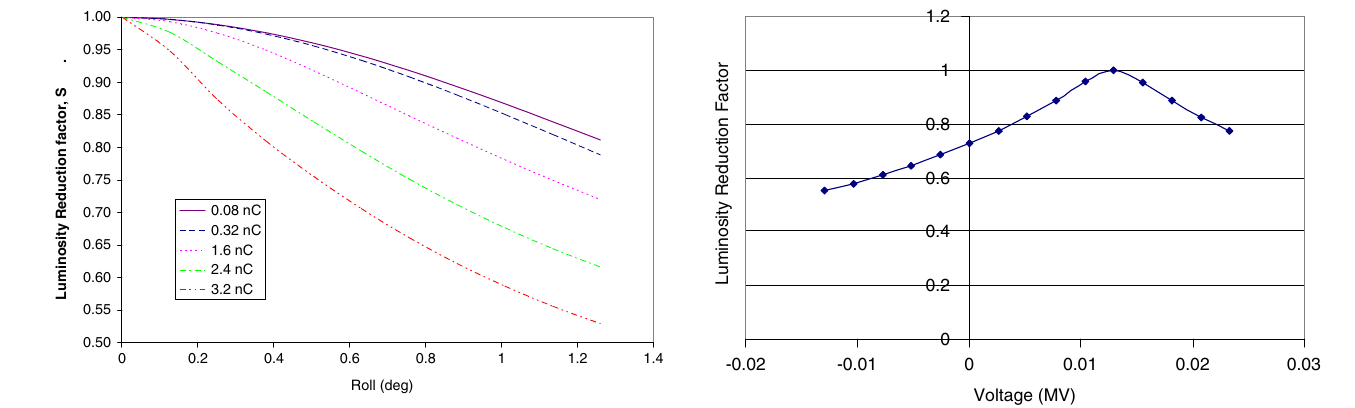
FIG. 8. (Color) Luminosity reduction factor as a function of the amplitude error on one anticrab cavity for a 10 mrad roll misalignment of the ILC crab cavity.